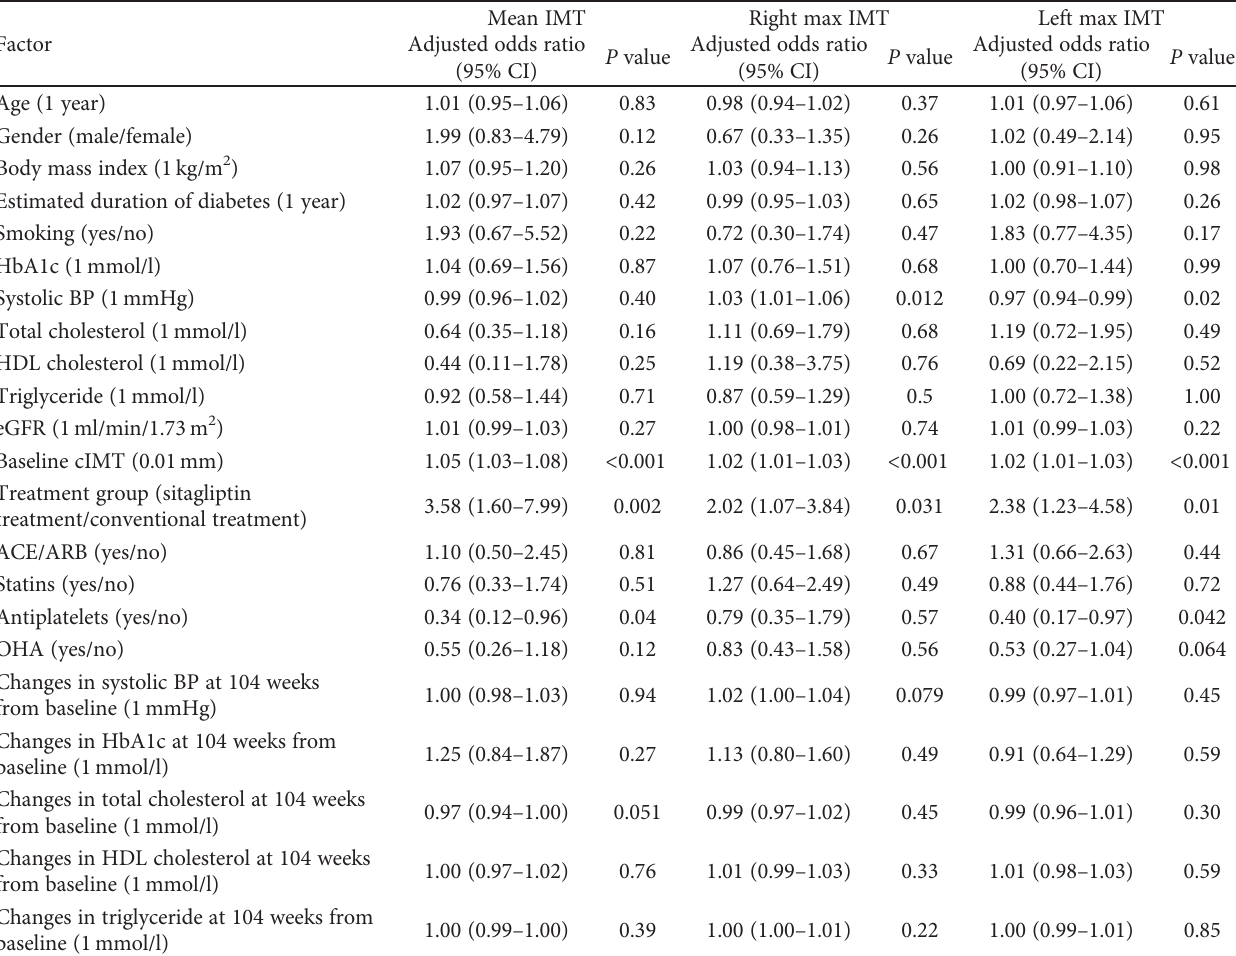
Table 4: Results of multivariate logistic regression models for the regression of IMT of ≥ 0.10 mm from baseline at the end of the